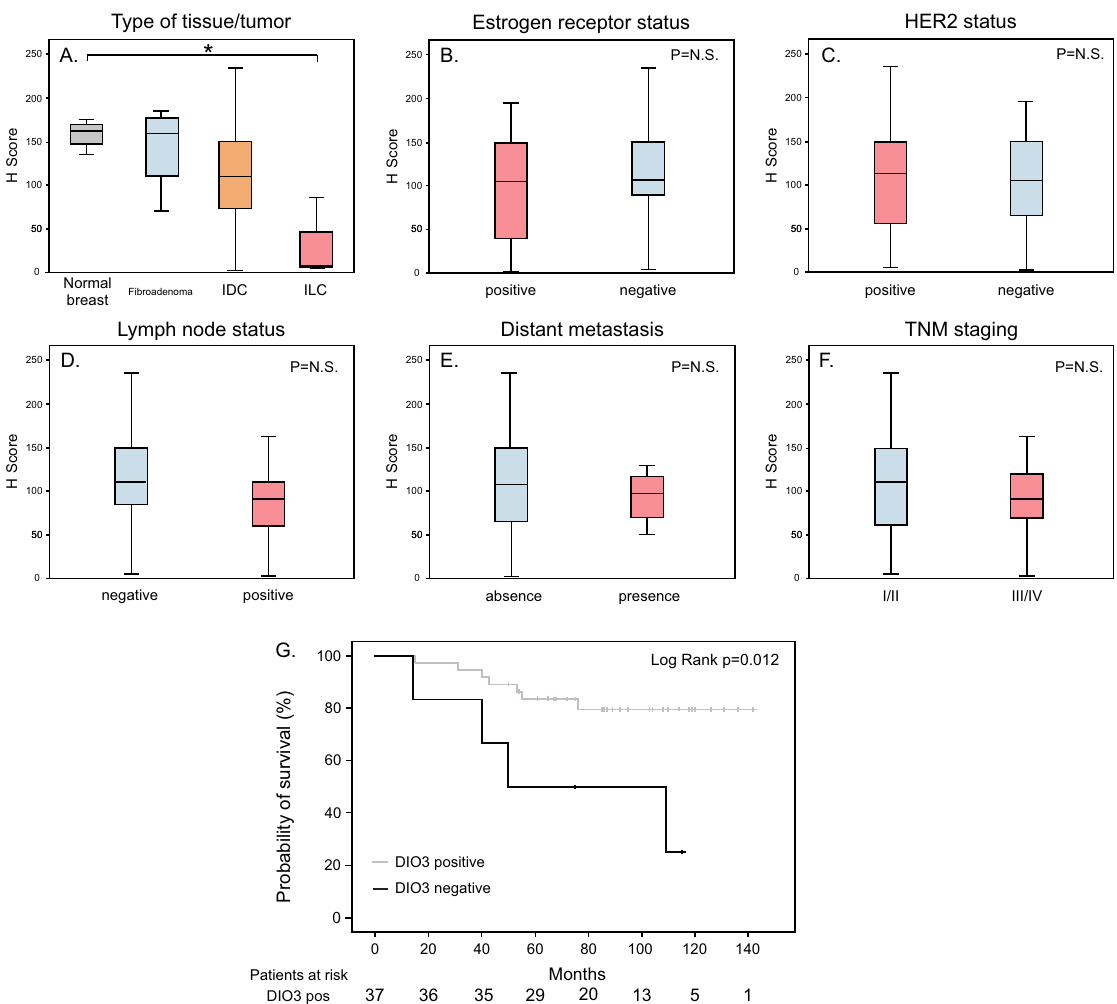
Figure 2. DIO3 staining and clinicopathological characteristics of patients with breast cancer in the primary cohort. ( A – F ) Box plots of DIO3 staining in breast tissue samples evaluated through immunohistochemistry and quantified by H-Score. Samples were divided according to clinicopathological data as follows: ( A ) type of tissue analyzed, ( B ) ER status, ( C ) HER2 status, ( D ) lymph node status, ( E ) distant metastasis and ( F ) TNM anatomic staging. ( G ) Kaplan–Meier plot of overall survival in patients with the presence (gray) or absence (black) of DIO3 staining in breast cancer evaluated through immunohistochemistry. ER estrogen receptor, HER2 human epidermal growth factor receptor2, IDC invasive ductal carcinoma, ILC invasive lobular carcinoma, N.S. not significant * P =